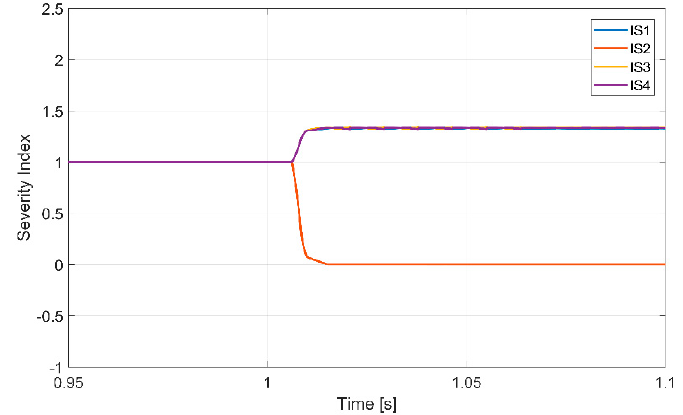
Figure 11. Diagnostic variables associated with the motor winding currents of the SRM at 1200 rpm in normal condition and open-circuit failure of power device S 1 B (simulation result).